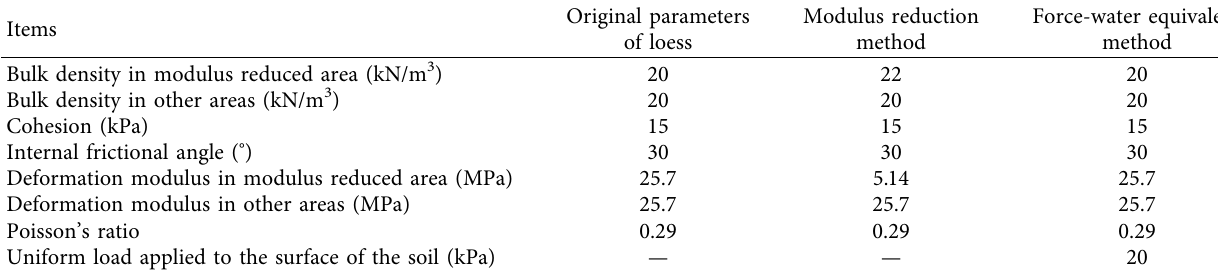
Figure 4: Schematic diagram of two calculation methods (unit: m): (a) modulus reduction method and (b) force-water equivalent method. Table 3: Input parameters comparison.